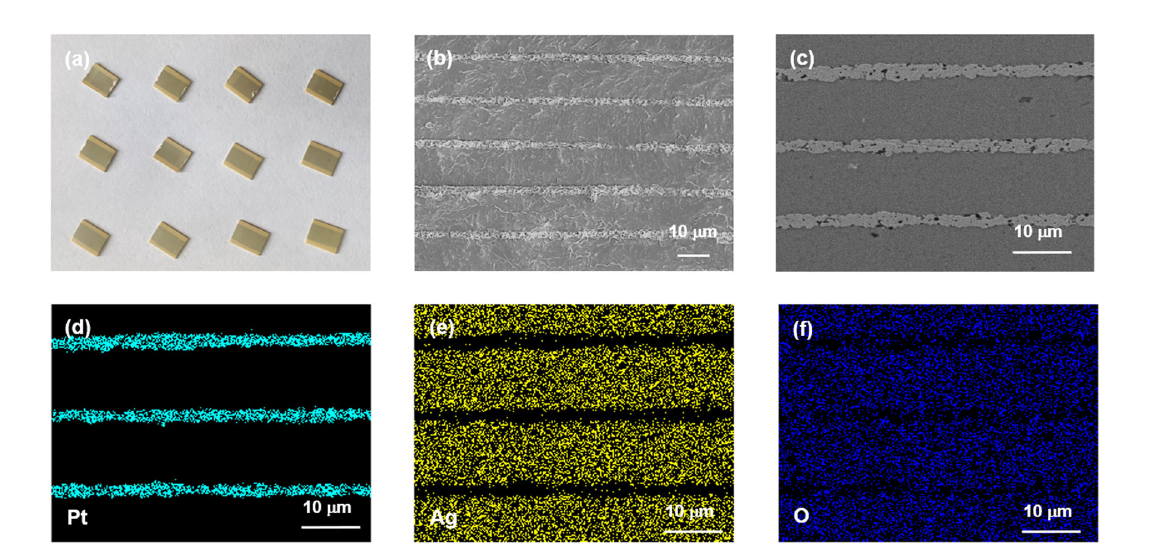
Fig. 3 | Microstructures of the SANT multilayer capacitors. Optical photo of the as-prepared SANT multilayer capacitors (size of the capacitor: length×width× height=6.0×4.5×0.5mm) ( a ). Cross-sectional SEM image ( b ), backscattered